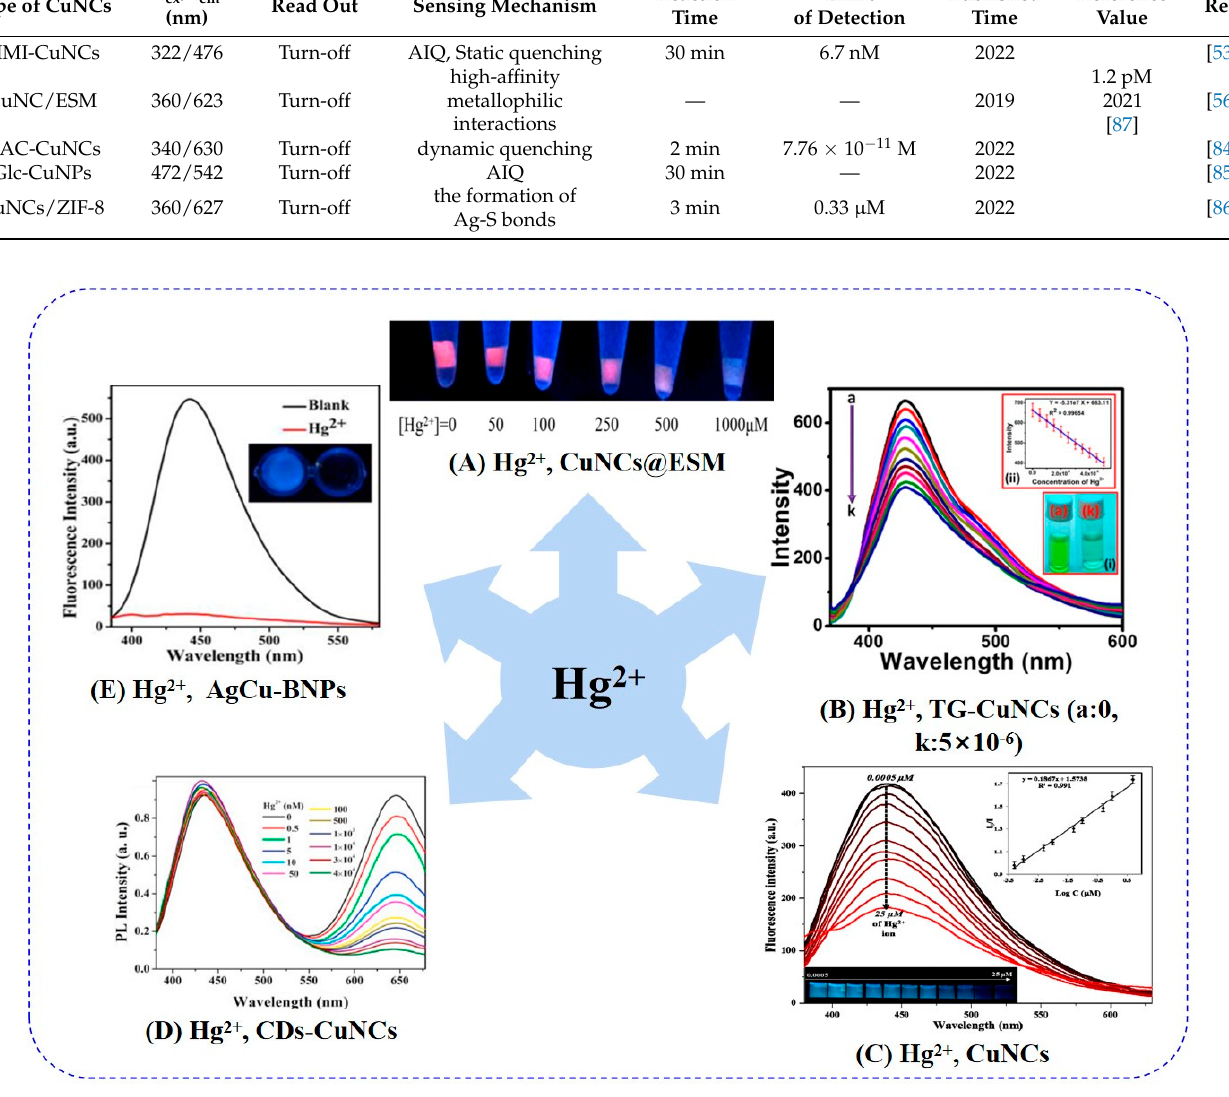
Figure 9. CuNCs for Hg 2+ detection. ( A ) The photo of CuNCs@ESM in the presence of Hg 2+ from 0 to 1000 μ M under a UV lamp [93], Copyrights from MDPI, 2018. Fluorescence spectra of different concentrations of Hg 2+ injected into ( B ) TG-CuNCs [94], Copyrights from Elsevier, 2020. ( C ) CuNCs [95], Copyrights from Royal Society Chemistry, 2018; and ( D ) CDs-CuNCs [96], Copyrights from Elsevier, 2021. ( E ) Fluorescence spectra of AgCu-BNPs and with Hg 2+ [97], Copyrights from Elsevier, 2021. Table 2. Report on detection of Hg 2+ by CuNCs.